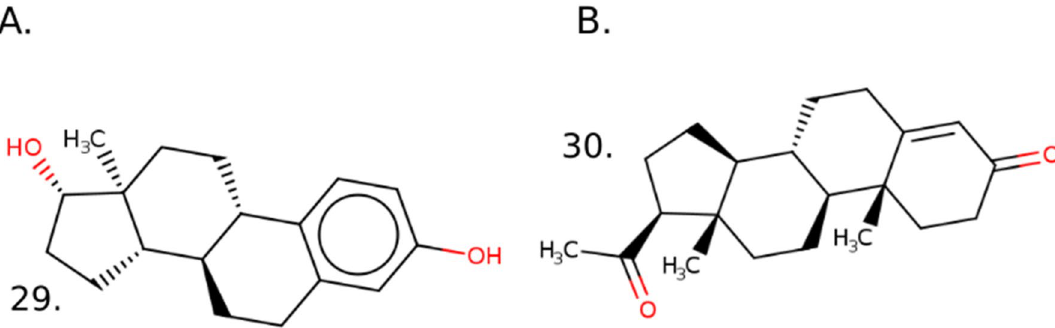
Figure 4. Chemical structure representation of ( A ) 29. Estradiol—E2 (DTXSID: DTXSID0020573, CASRN: 50–28–2) ( B ) and 30. Progesterone—P4 (DTXSID: DTXSID3022370, CASRN: